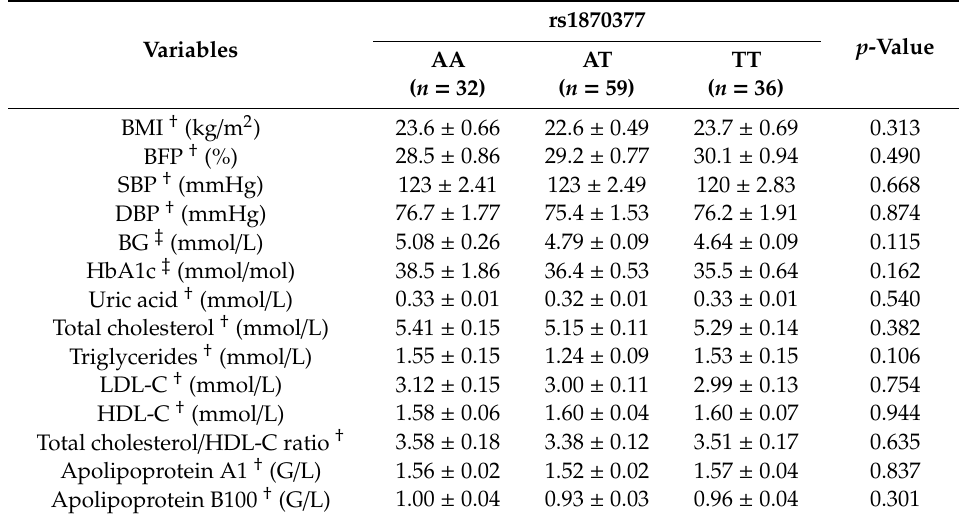
Table 2. Values of cardiometabolic risk parameters according to genotype of VEGFR-2 gene rs1870377 single-nucleotide polymorphism, SNP ( n =